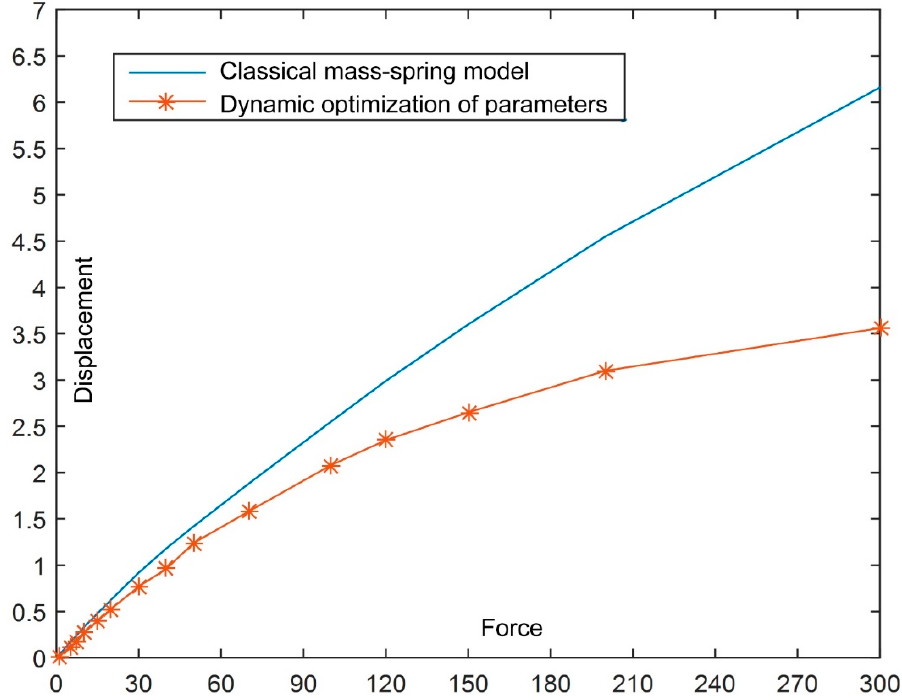
Figure 12. Comparison diagram of force vs. displacement.